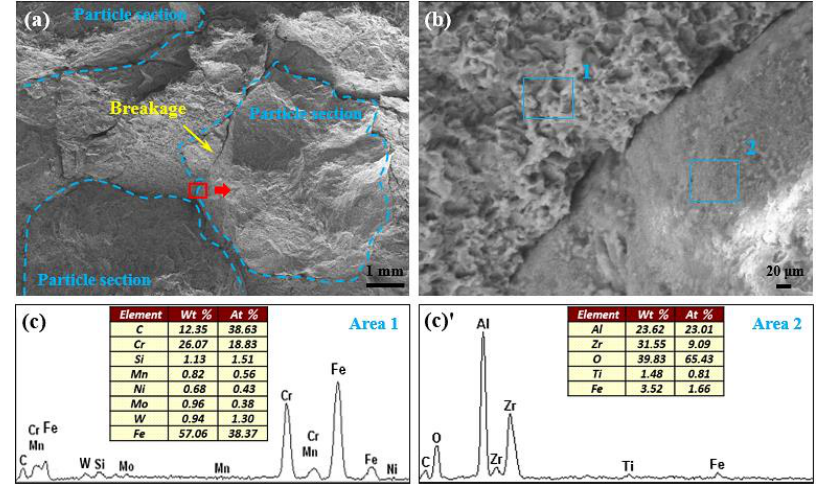
Figure 6. ( a ) Fracture surface of the composite at low magnification; ( b ) Fracture surface of the composite at high magnification; ( c , c ′) EDS (energy dispersive spectrometer) analysis results of the regions 1 and 2 in ( b ).